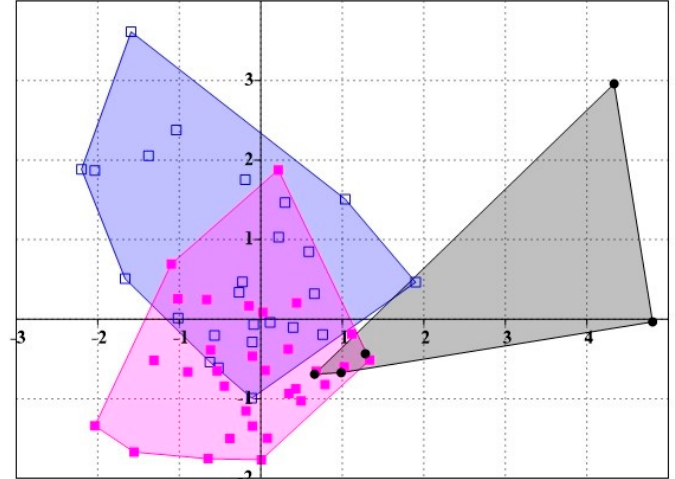
Figure 2. Canonical variate analysis (CVA) ordinance diagram showing the differences in the accumulation of heavy metals between the tested mushroom families. Open squares mean the Boletaceae family, painted squares mean Russulaceae , and black circles mean the Suillaceae family. Wilk’s test λ = 0.46. First axis explained 45.1% of variance and second axis explained 24.0% of variance.